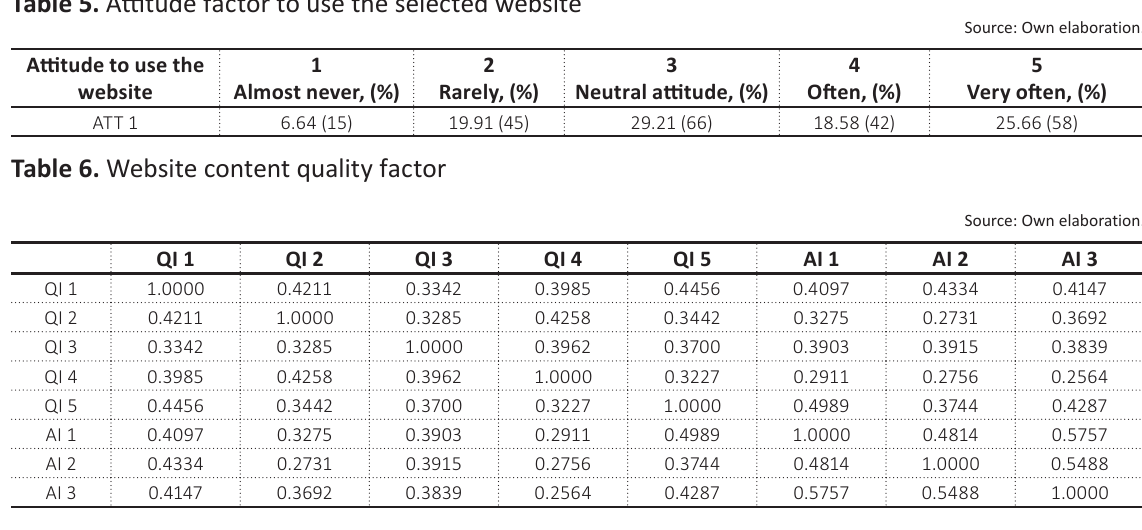
Table 5. Attitude factor to use the selected website